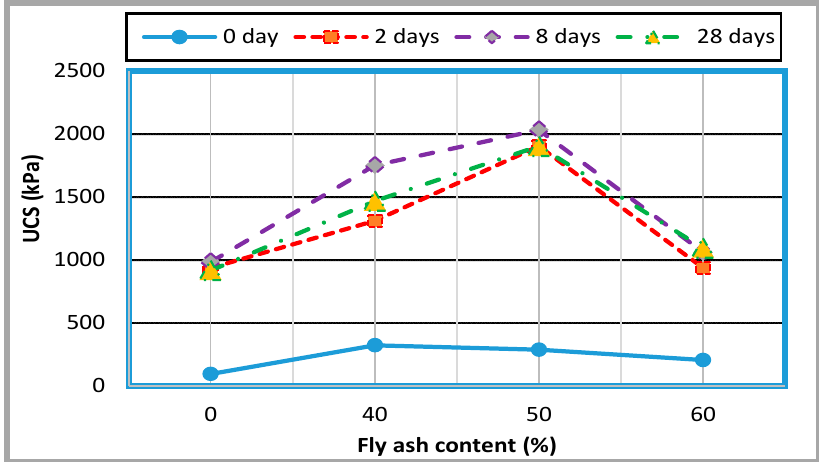
Figure 8. Variation of UCS with fly ash content.